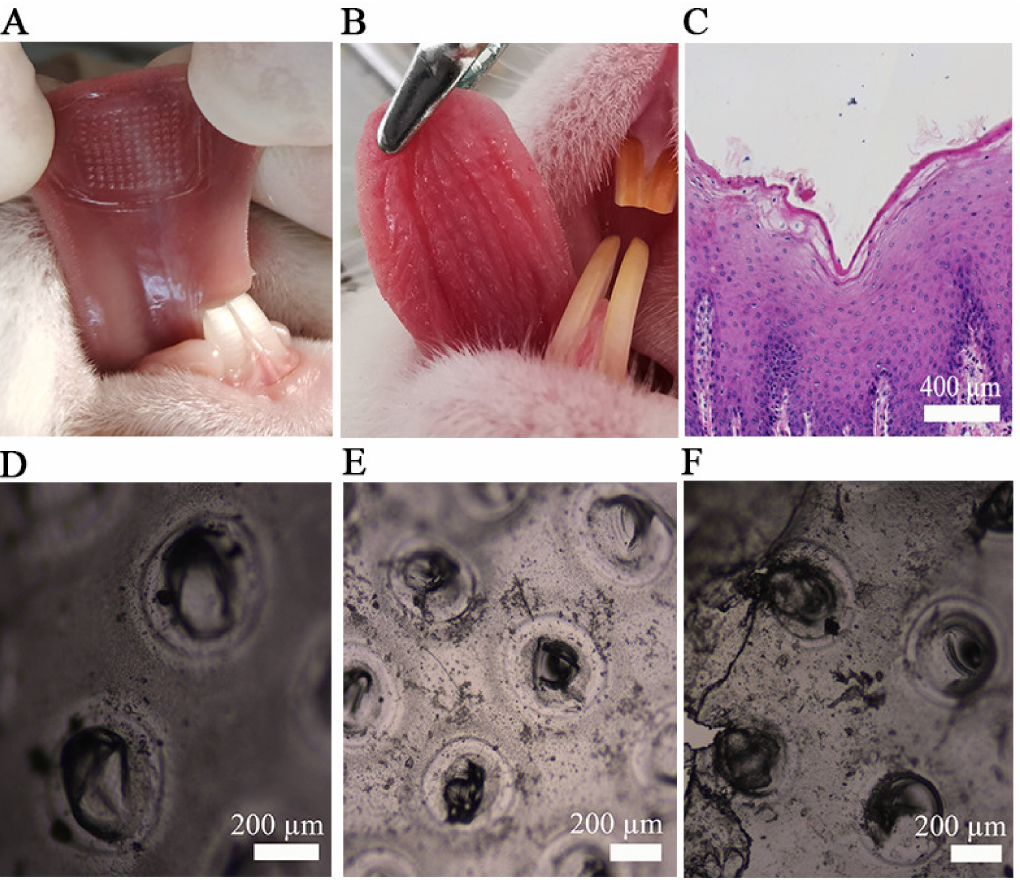
Figure 4. The results of the mucosa insertion test. ( A ) Image of the rabbit tongue abdomen mucosa treated with Li-HAMNs. ( B ) The photograph of the rabbit tongue abdomen mucosa surface after insertion of Li-HAMNs. ( C ) Image of H&E staining section of pig oral mucosa after the application of Li-HAMNs. ( D – F ) Image of Li-HAMNs after rabbit tongue abdomen mucosa dissolution under an optical microscopy image for 1 min ( D ), 2 min ( E ), and 3 min ( F